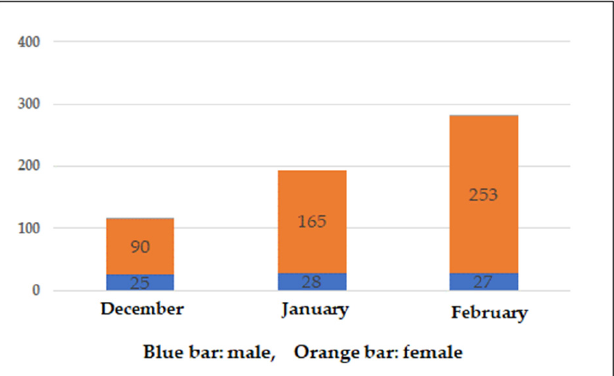
Figure 2. Number of monthly Choisoko reservations. Blue bar indicates male. Orange bar indicates female.